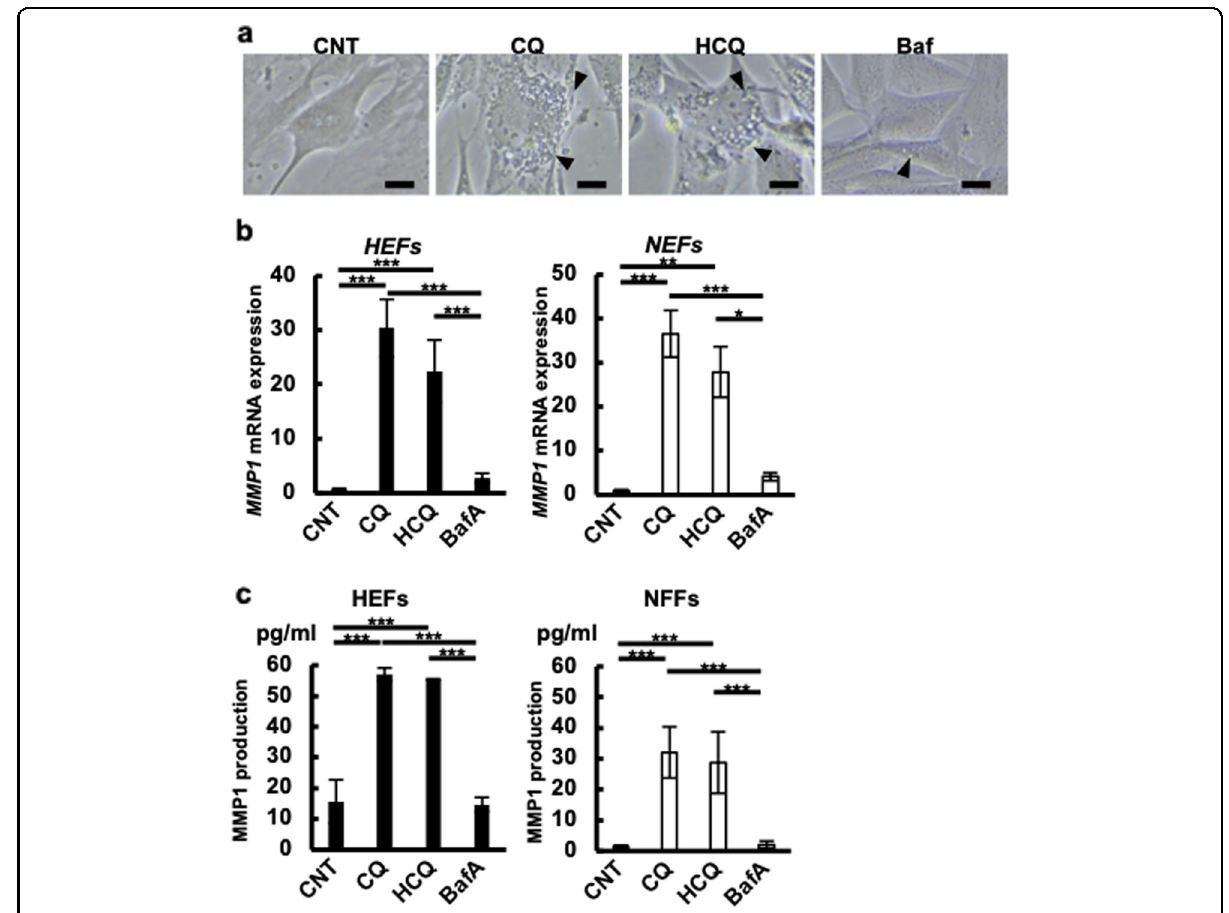
Fig. 3 Lysosomotropic agents upregulated MMP1 expression. Three cell lines of each of HEFs and NFFs were cultured in triplicate wells and treated with 50 μ M CQ, 50 μ M HCQ, 5 nM BafA, or vehicle. a Representative cell morphology of NFFs treated with the indicated drugs or vehicle. Arrowheads indicate vesicles. Scale bar indicates 1 μ m. b Relative MMP1 mRNA expression in 24 h of treatment is shown. c MMP1 proteins in culture medium upon 48 h of treatment with lysosomotropic agents were analyzed by ELISA. Black bar indicates expression in HEFs and white bar indicates expression in NFFs ( b , c ). The data represented the mean ± SEM of the three independent